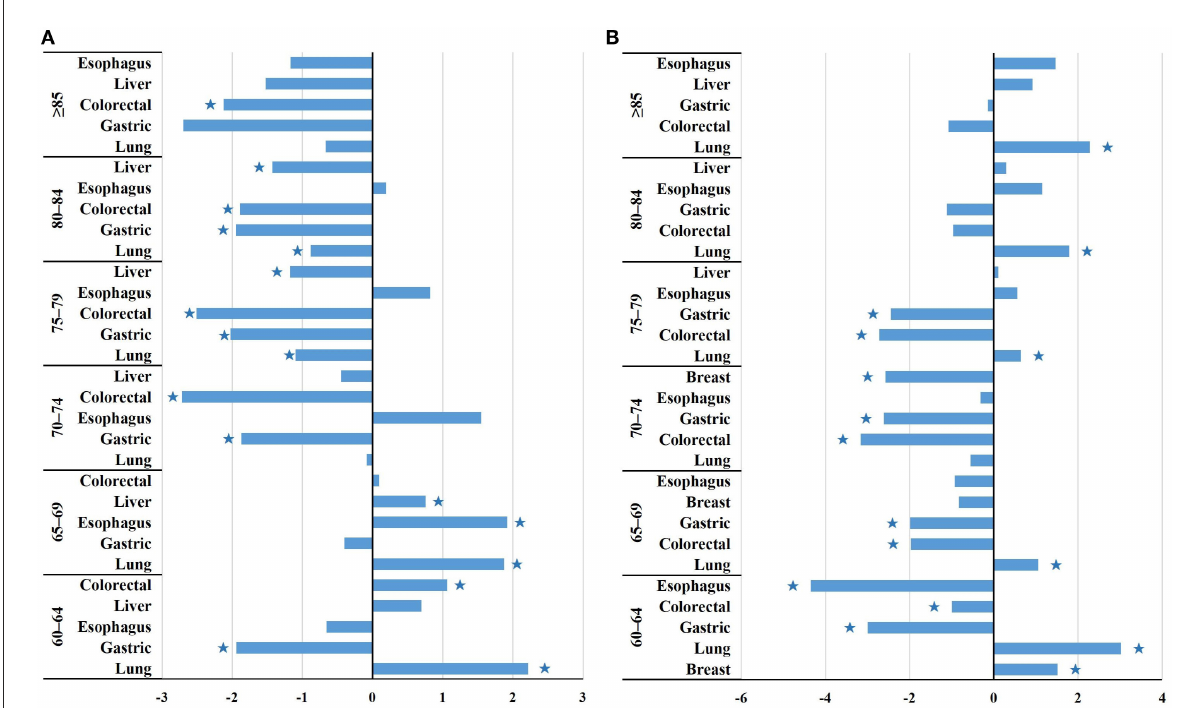
FIGURE4 The changing trend of the incidence of the top five cancers among Chinese older adults aged 60 and above of different genders and different age groups from 2005 to 2016. * P < 0.05. (A) Male. (B) Female.